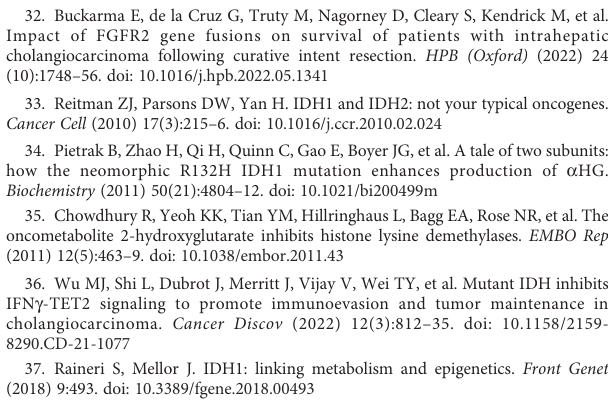
fi broblast growth factor receptor rearrangement. Transl Oncol (2021) 14(10):101168. doi: